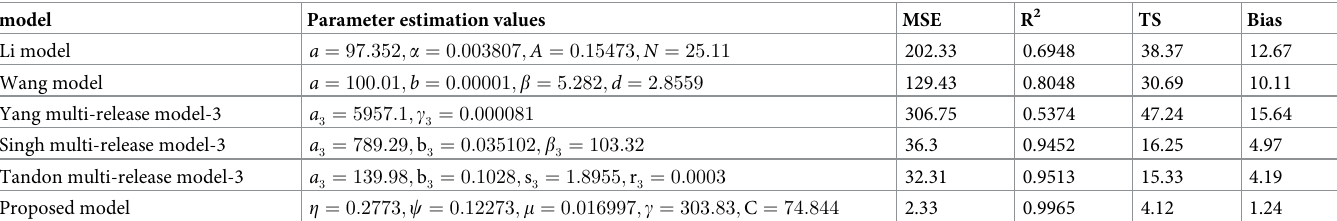
Table 4. Comparison of the fitting performance of models using 100% of fault data (DS1-3). model